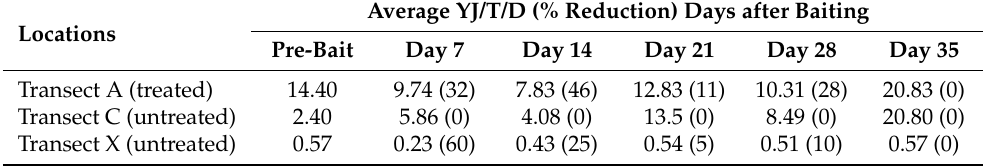
Table 4. The average number of yellowjackets trapped per trap per day (YJ/T/D) and percent reduction after baiting with 0.022% fluralaner PAA bait at the Richmond Field Station a .